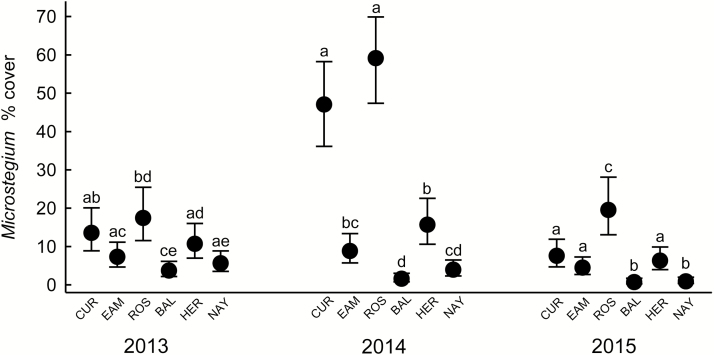
Fall cover (%) of Microstegium vimineum in seed addition plots within six suburban forests in central New Jersey. Data are combined across fenced and deer access plots and are means ± 95 % CI (back-transformed from logits) of 16–20 plots. Different letters above the mean indicate significant differences within a year (Tukey–Kramer adjusted P < 0.05).